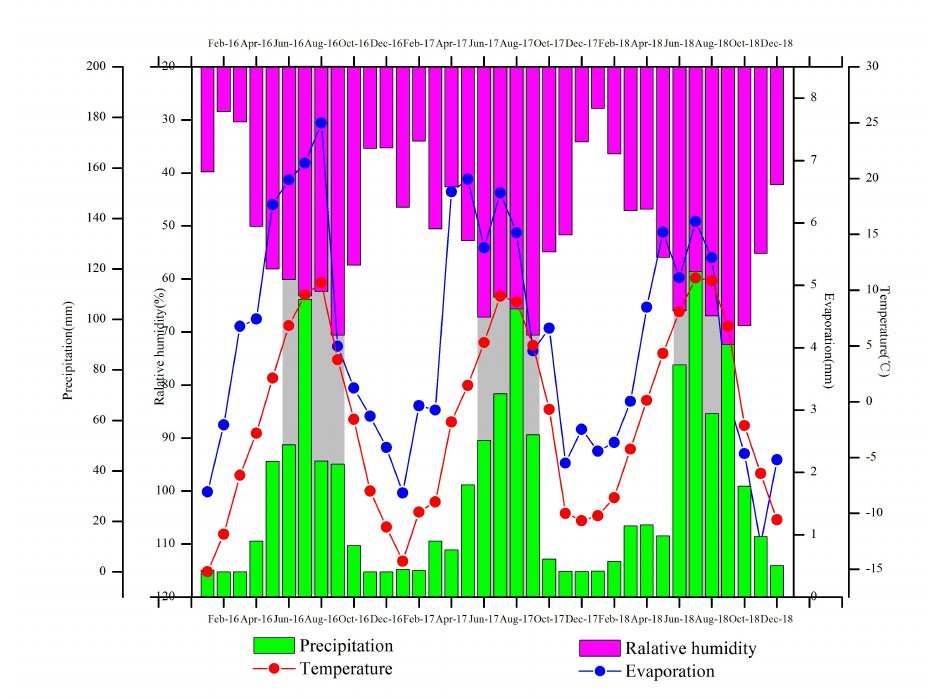
Figure 10. Variation in meteorological factors during the sampling period (shadow represents the ablation